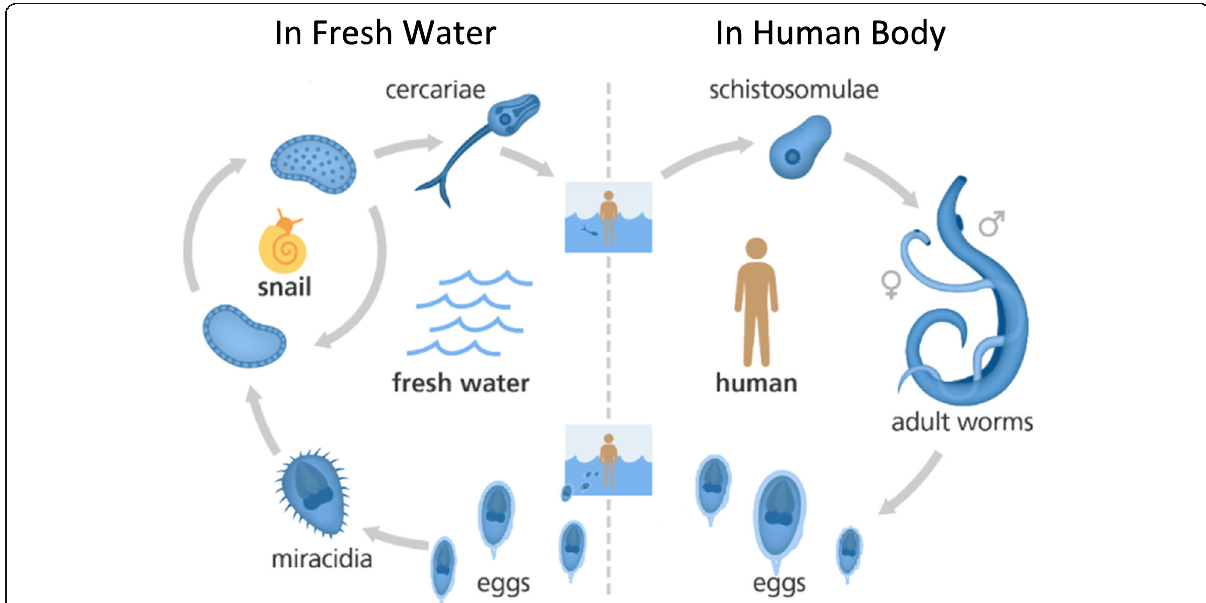
Fig. 1 Life cycle of Schistosoma haematobium in freshwater (asexual reproduction in the snail) and in the human body (sexual reproduction in genitourinary